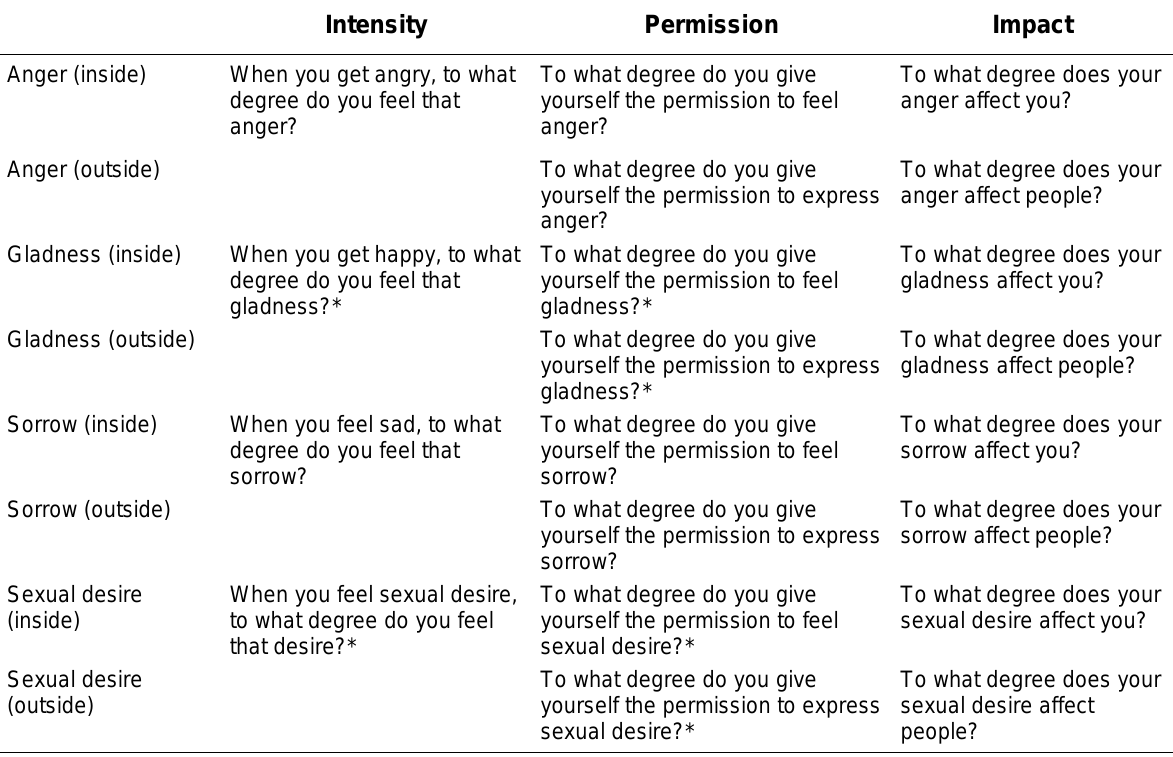
Construction of the SOC-E